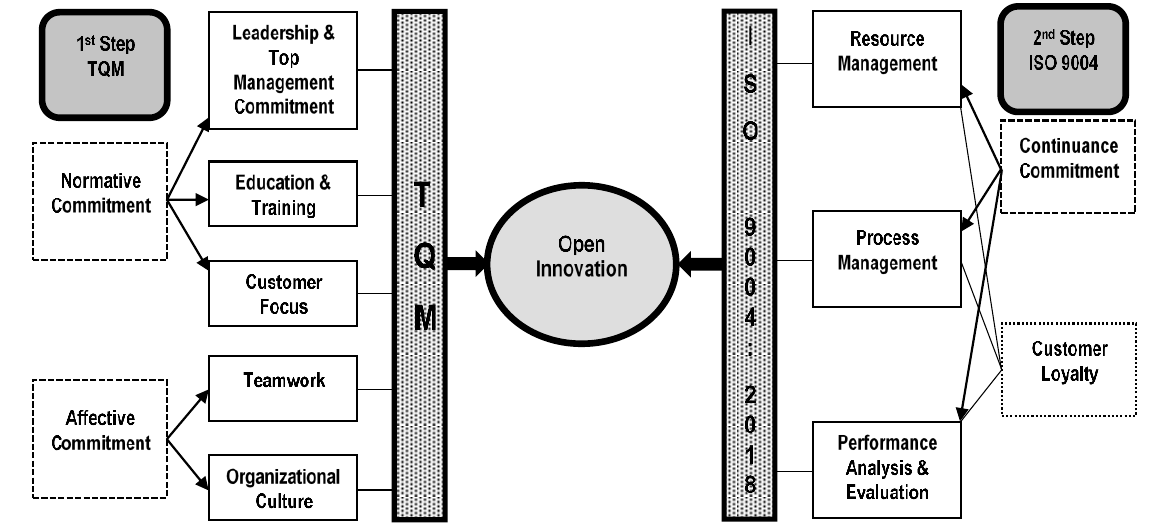
Figure 1. Open innovation supported by TQM (1) and ISO 9004:2018 (2).